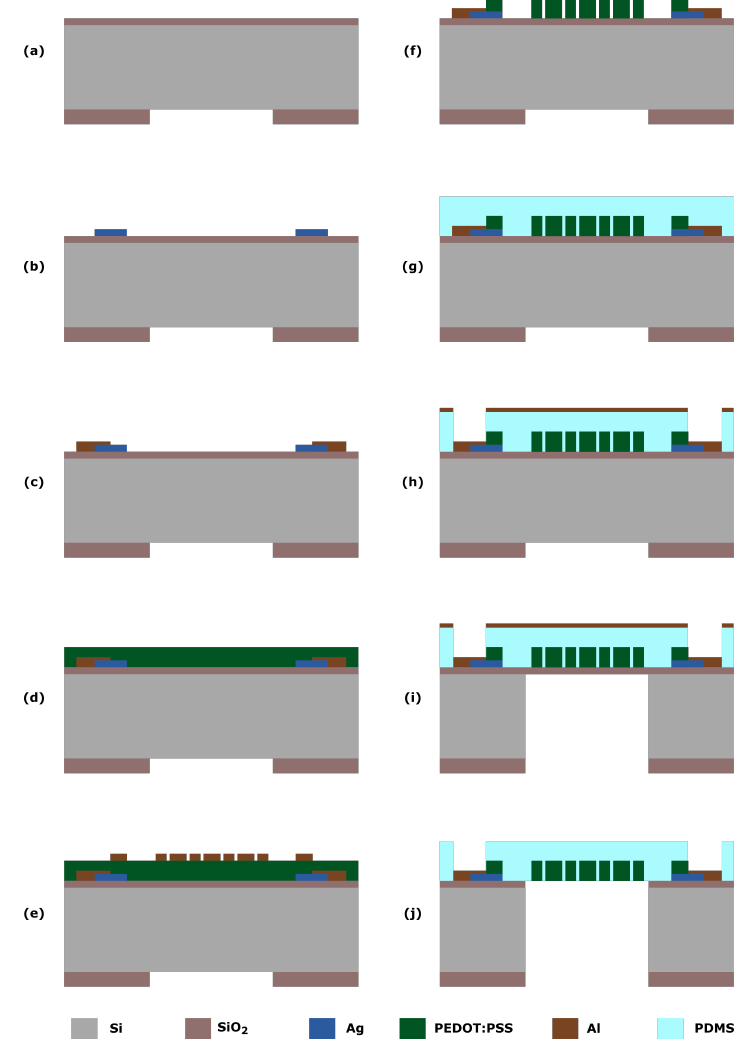
Figure 4. The main steps of the process flow developed for the wafer-scale fabrication of polymeric strain gauges. ( a ) Front and back deposition of the SiO 2 oxide and patterning to define the membranes